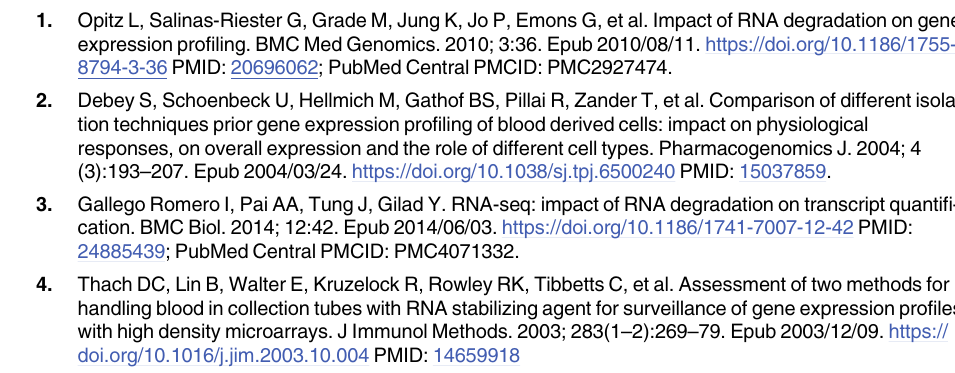
S1 Fig. Scatterplot: Scatterplot representing correlation between donors and preservation methods (A) PAXgene 1 vs PBMCs (B) RNAgard 1 vs PAXgene 1 (C) PBMCs vs RNAgard 1 .